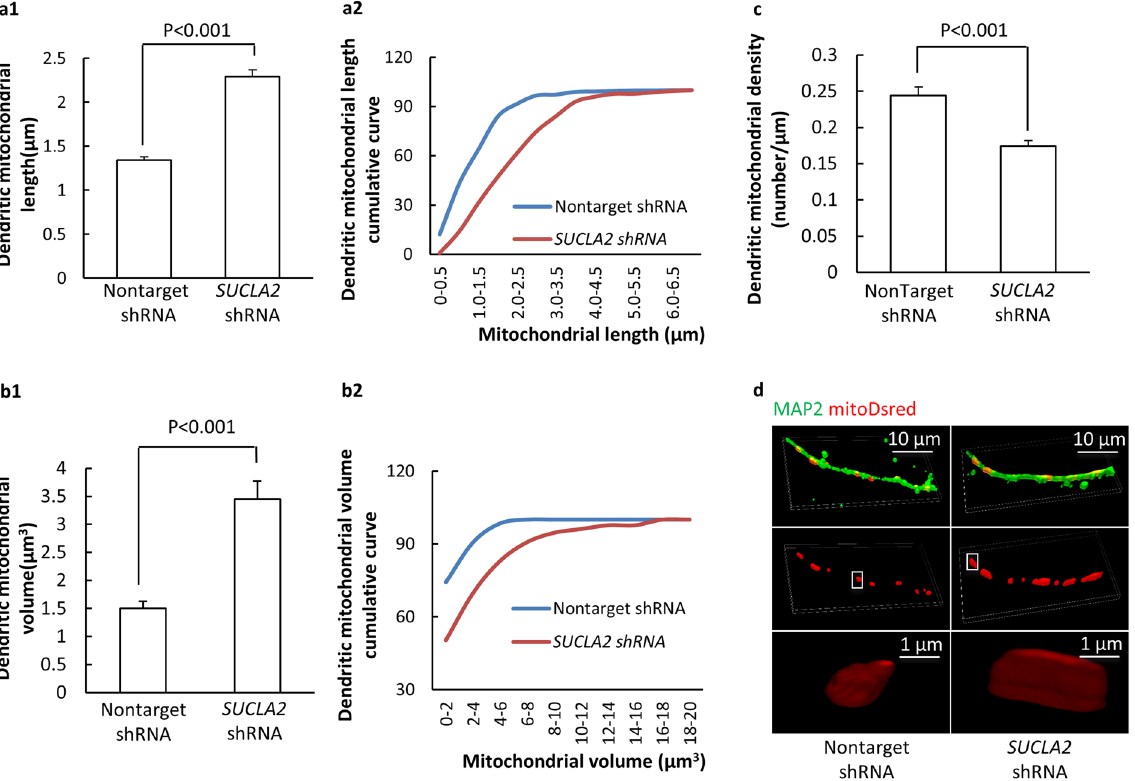
Figure 6. Loss of SCS A- β disrupts neuronal mitochondrial dynamics. ( a1 ) Dendritic mitochondrial length in SUCLA2- and nonTarget-shRNA-treated neurons. ( a2 ) Analysis of the cumulative fraction of mitochondrial length. Data were collected from 400 mitochondria. ( b1 ) Dendritic mitochondrial volume in SUCLA2- and nonTarget-shRNA-treated neurons. ( b2 ) Analysis of the cumulative fraction of mitochondrial volume. Data were collected from 400 mitochondria. ( c ) Dendritic mitochondrial density in SUCLA2- and nonTarget- shRNA-treated neurons. Data were collected from 24 neurons per group. ( d ) are representative images of mitoDsred. Scale bar = 10 µ m for upper panels, = 1 µ m for enlarged mitochondria.